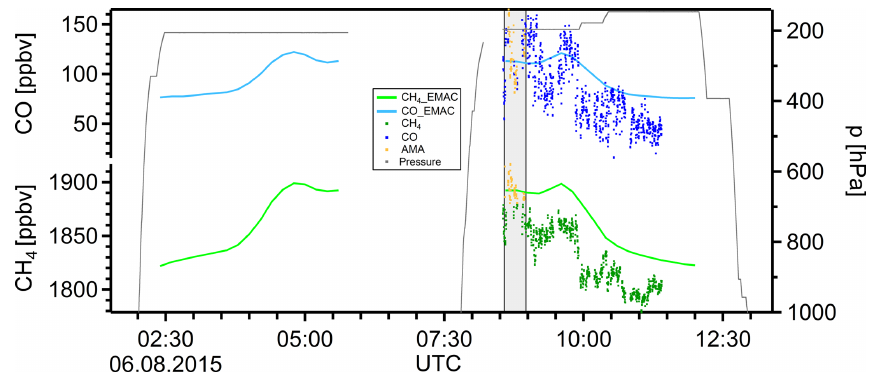
Figure 22. Flight 12/13 (6 August 2015) in situ CH 4 and CO data and EMAC results along the flight track, as well as the flight altitude. The AMA is colour-coded by CH 4 >1879.8ppbv.